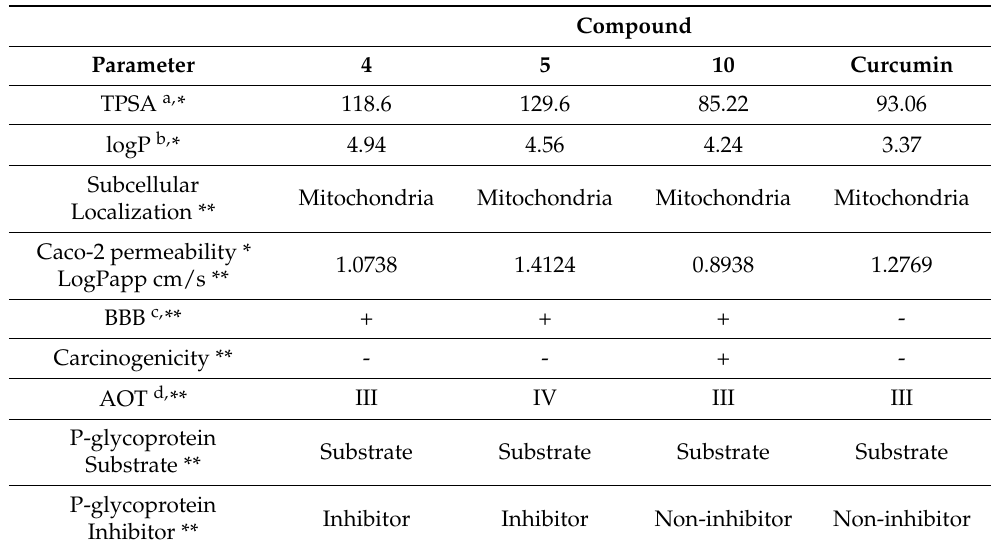
Table 2. The prediction of ADMET properties for compounds 4 , 5 , 10 , and curcumin.